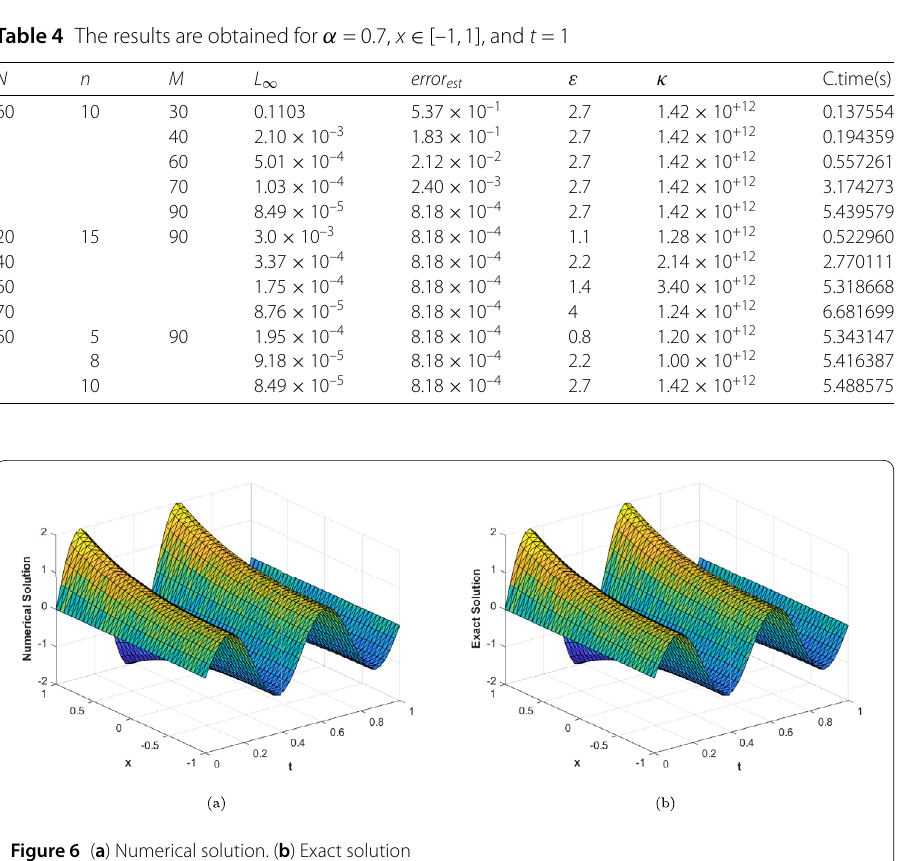
The initial and boundary conditions are extracted from the exact solution. The results obtained for different nodes n ∈ (cid:3) i , N ∈ (cid:3) and different quadrature nodes with α = 0.3, α = 0.7 are shown Table 3 and Table 4. A clear improvement is observed in the accuracy as we increase the spatial and quadrature nodes. The plots of exact and numerical solutions are given in Fig. 6(a) and in Fig. 6(b). In Fig. 7(a) the contour plot of the absolute error is given, which shows a high accuracy of the proposed numerical scheme. In Fig. 7(b) the plot of the actual error and error estimate is shown, which shows good agreement between them. The results ensure the convergence, stability, and efficiency of our